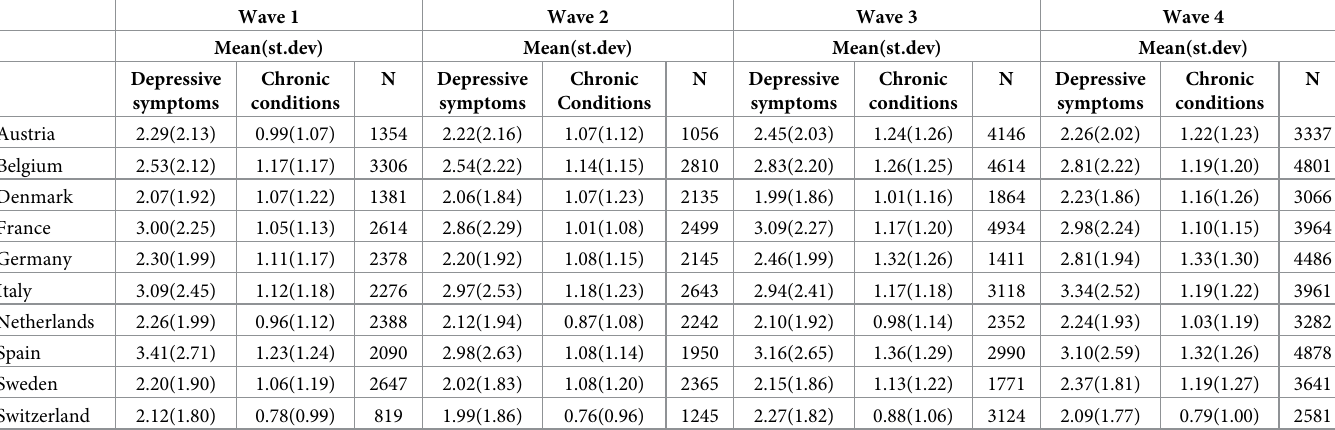
Table 1. Depressive symptoms (EURO-D) over time by